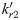
WEE1 and CDC25C regulation of preMPF and activation of MPF kinase.(A) Approximated steady-state protein levels from studies by Potapova et al. [9] using immunoblot analysis for CCNB1T, CDK1T, CDK1P (i.e. preMPF), phosphorylated H3 S10P, APC3 (i.e. APC/CT), APC3P (i.e. APC/CP) in HeLa cells following release from synchronization in the S/G2 phase. Arrows mark points of comparison between in vitro and in silico data. (P, phosphorylated protein; T, total protein) (B) Simulation of WEE1 kinase (kr2′) and CDC25C phosphatase (kf2′) activities in regulating oscillations in CDK1T, LMNAP, APC/CT, APC/CP, CDC25CT, CDC25CP, preMPF (CCNB1:CDK1P), and active MPF kinase (CCNB1:CDK1) over the indicated time periods. Boxed area is magnified. (C) Approximated steady-state protein levels for APC3P, CDK1T, and H3 S10P from studies by Potapova et al. [9] involving chemical inhibition (+) of WEE1 kinase activity using synchronized HeLa cells compared to control. (D) Inhibition of WEE1 with inhibition of CDC25 (+) activities in synchronized HeLa cells by Potapova et al. [9] and associated changes in APC3P, CDK1T, and H3 S10P resulting in a mitotic collapse. (E) Simulated inhibition of WEE1 kinase (kr2′) and associated changes oscillations in CDK1T, LMNAP, APC/CT, APC/CP, CDC25CT, CDC25CP, preMPF (CCNB1:CDK1P), and active MPF kinase (CCNB1:CDK1) over the indicated time period. Also, simulated inhibition of both WEE1 (kr2′) and CDC25C (kf2′) and associated changes resulting in a mitotic collapse.